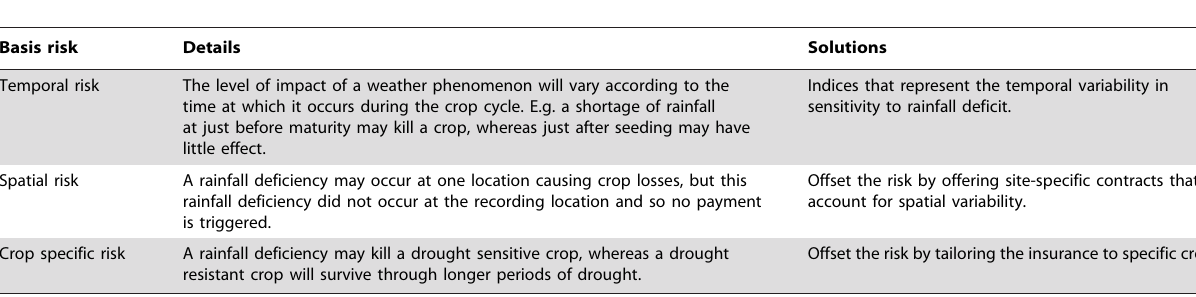
Table 2. Summary of main challenges that need to be addressed and possible areas of action.